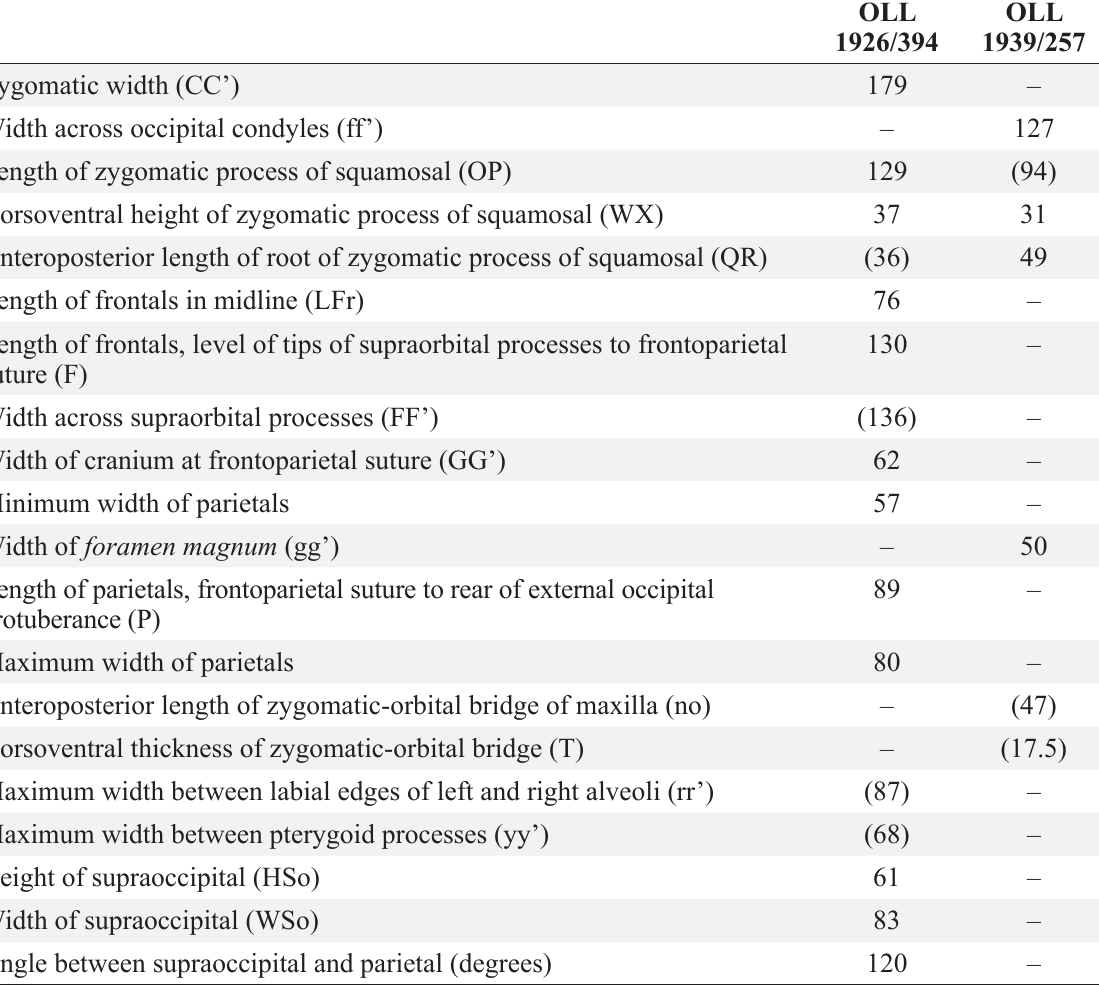
Table 2. Measurements (in mm if not otherwise stated) of crania of Lentiarenium cristolii (Fitzinger, 1842). Letters in parentheses denote the standard dimensions established by Domning (1978: fig. 7, table 2). Measurements in parentheses indicate preserved